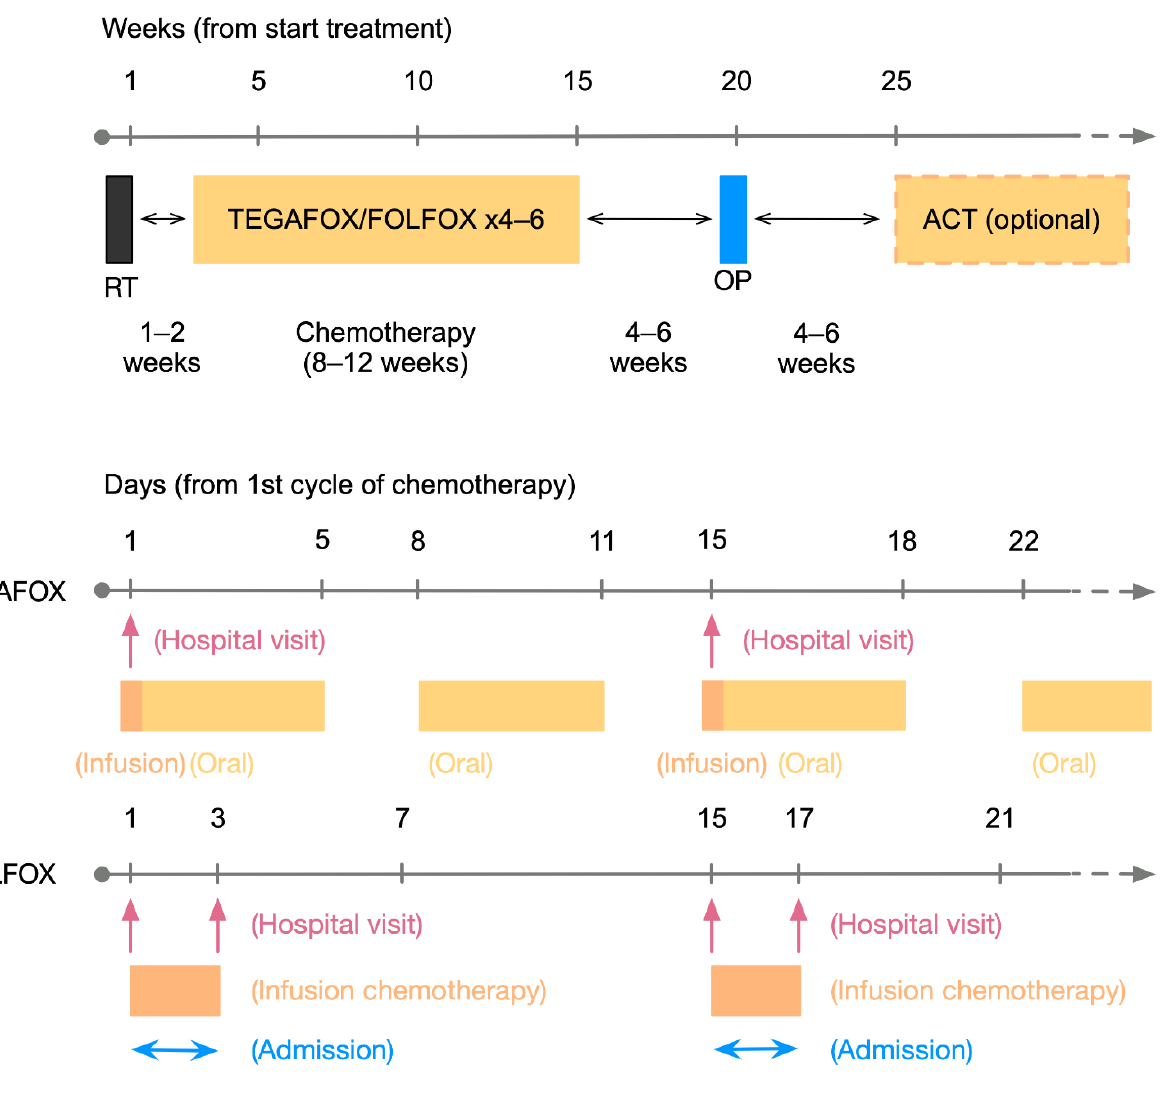
Figure 2. ( A ) The timeline of each individual therapeutic intervention in this study; ( B ) The detailed timeline of the 1st and 2nd cycle of consolidation chemotherapy. RT: radiotherapy; OP: operation; ACT: adjuvant chemotherapy.